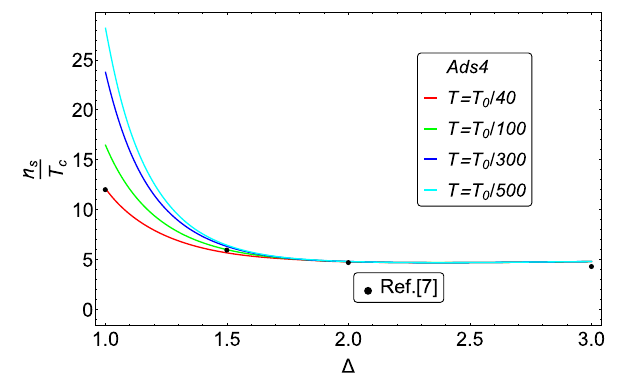
Fig. 9 n s / T c vs (cid:2) for d = 3.Coloredreallinesareplotsofouranalytic results while the black points are numerical data of Ref. [7]. Notice that it is almost independent of T and (cid:2) over the region 2 ≤ (cid:2) ≤